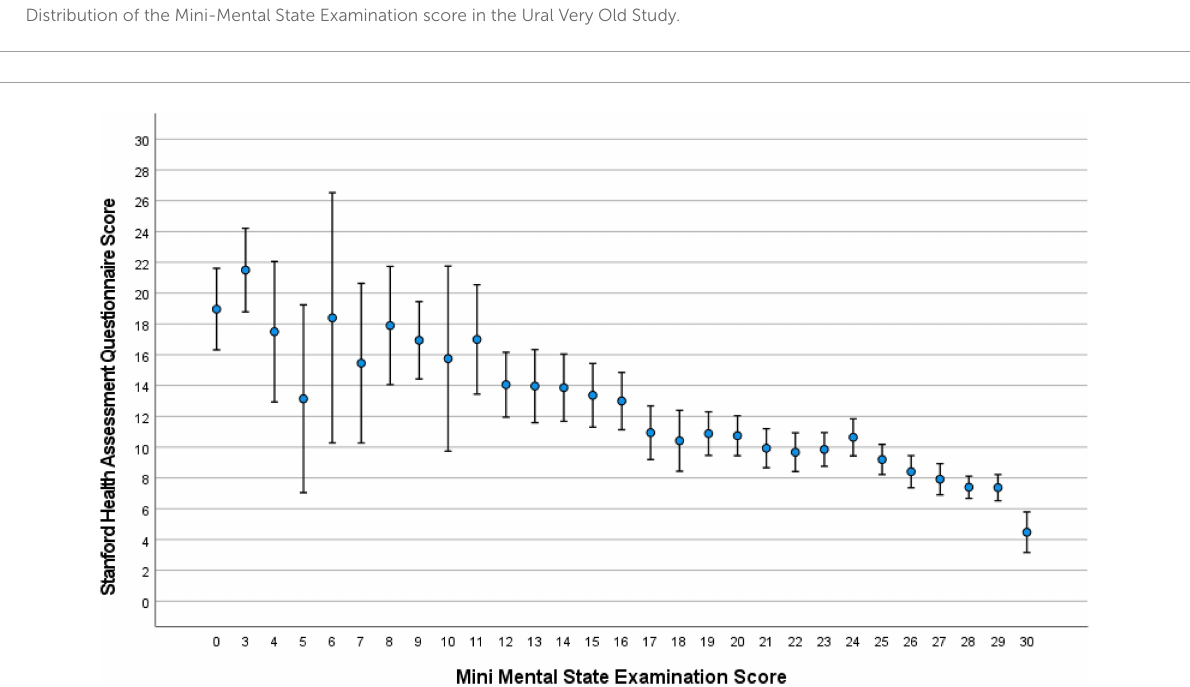
FIGURE2 Distribution of the Stanford Health Assessment Questionnaire score, stratified by the Mini-Mental State Examination score, in the Ural Very Old